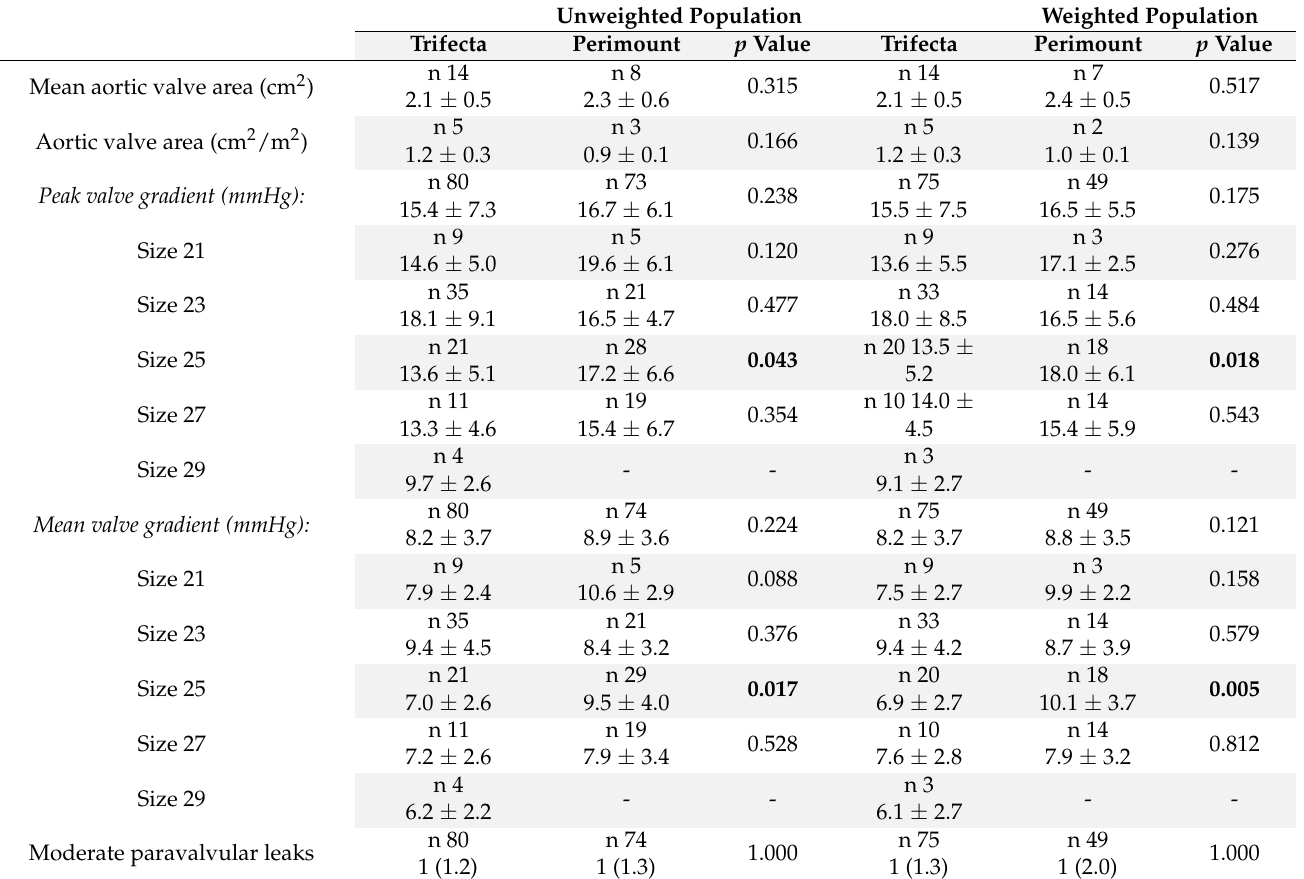
Table 5. Valve hemodynamic performance at follow-up in the unweighted and weighted